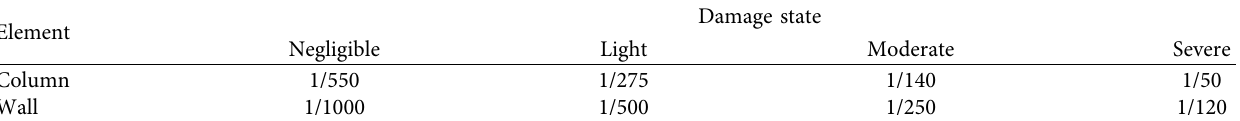
Table 6: Drift ratio limitations for column and wall at different damage